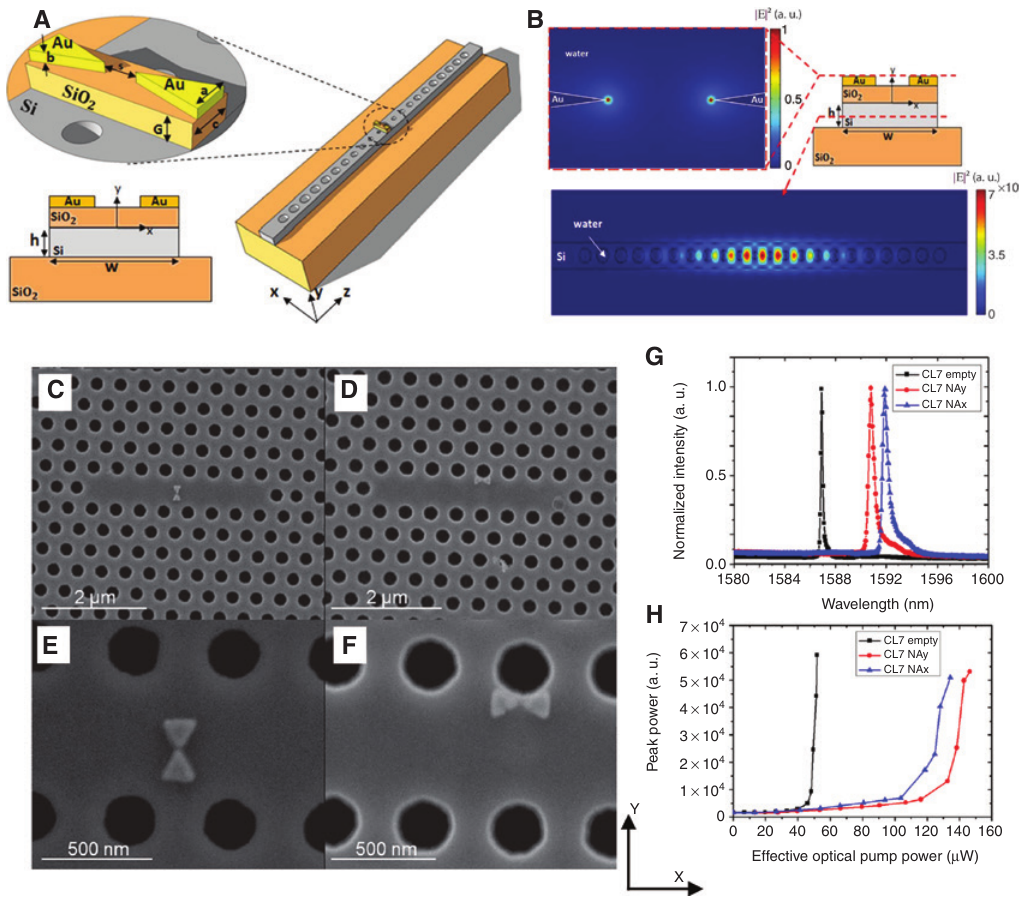
Figure 30: Photonic crystal nanobeam cavity with a gold bowtie nanoantenna. (A) Hybrid photonic-plasmonic device configuration, featuring a gold plasmonic nanoantenna supported by a dielectric layer on a silicon PhC nanobeam cavity. (B) Computed relative intensity distribution at the surface of the bowtie (top) and in the PhC nanobeam (bottom). Adapted from [173]. (C)–(F) SEM images of a hybrid nanolaser encompassing a linear PhC microcavity and gold bowtie nanoantenna where (C) the nanoantenna is at the centre and (D) at the edge of the PhC microcavity. The respective magnified images are (E) and (F). (G) and (H) Performance characterisation of the hybrid nanolaser with and without the plasmonic nanostructure. Here, the (G) normalised lasing spectra and (H) peak versus optical pump power are plotted. Adapted from